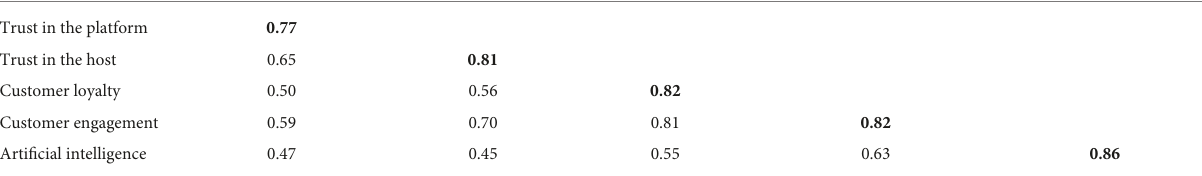
TABLE 5 Descriptive statistics, correlations, average variance extracted (AVE), and reliability.